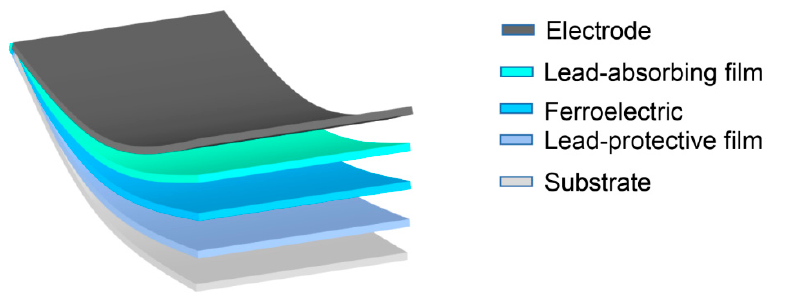
Figure 11. Imagination of Lead Sequestration Model Diagram. Composition structure (Electrode/Lead-absorbing film/Ferroelectric/Lead-protective film/Substrate).